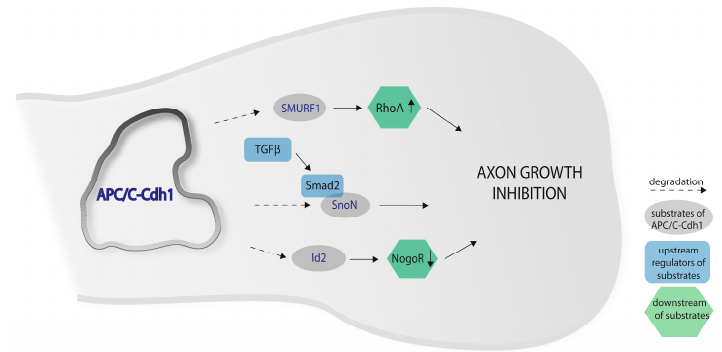
Figure 1. Anaphase Promoting Complex/Cyclosome regulates axon growth. APC/C-Cdh1 targets the ubiquitin ligase Smurf1 for degradation, which allows for the accumulation of RhoA, a potent regulator of axon growth. TGF β /Smad2 signaling recruits APC/C-Cdh1 to its substrate SnoN, an axon growth stimulating protein. The destabilization of the transcription factor Id2 limits the expression of genes with inhibitory effect on axonal growth like the Nogo Receptor.